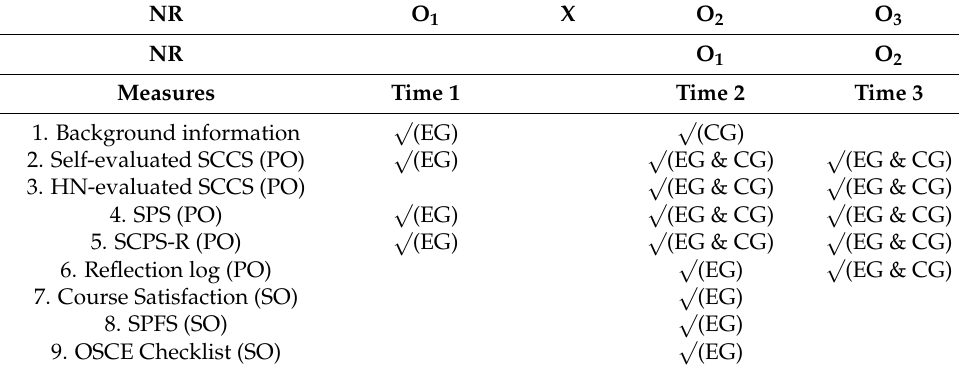
Table 1. Study Design and Collection Points of